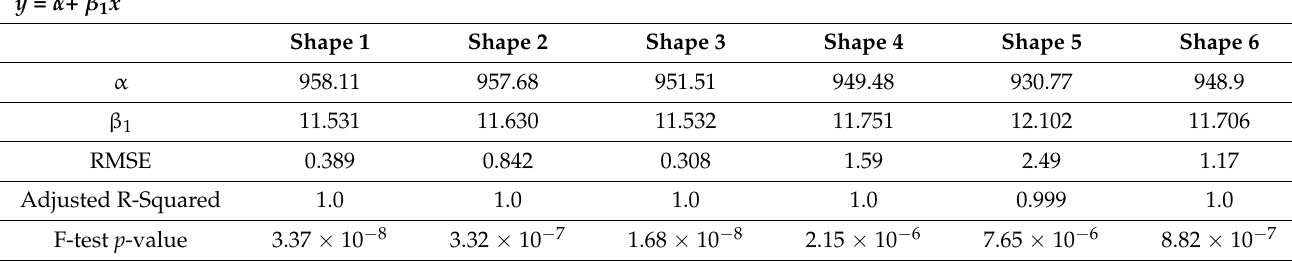
Table 13. Fitted lines of lighting